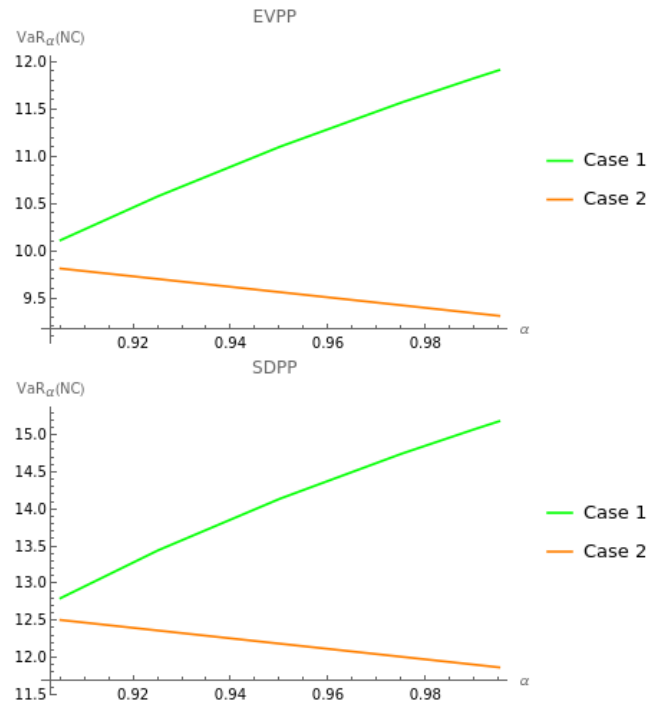
Figure 3. Effects of α on VaR α ( NC; c ∗ , d ∗ , υ ∗ ) for Case 1 and Case 2 under the EVPP and SDPP when θ = 0.2 and p = 0.5 are fixed.